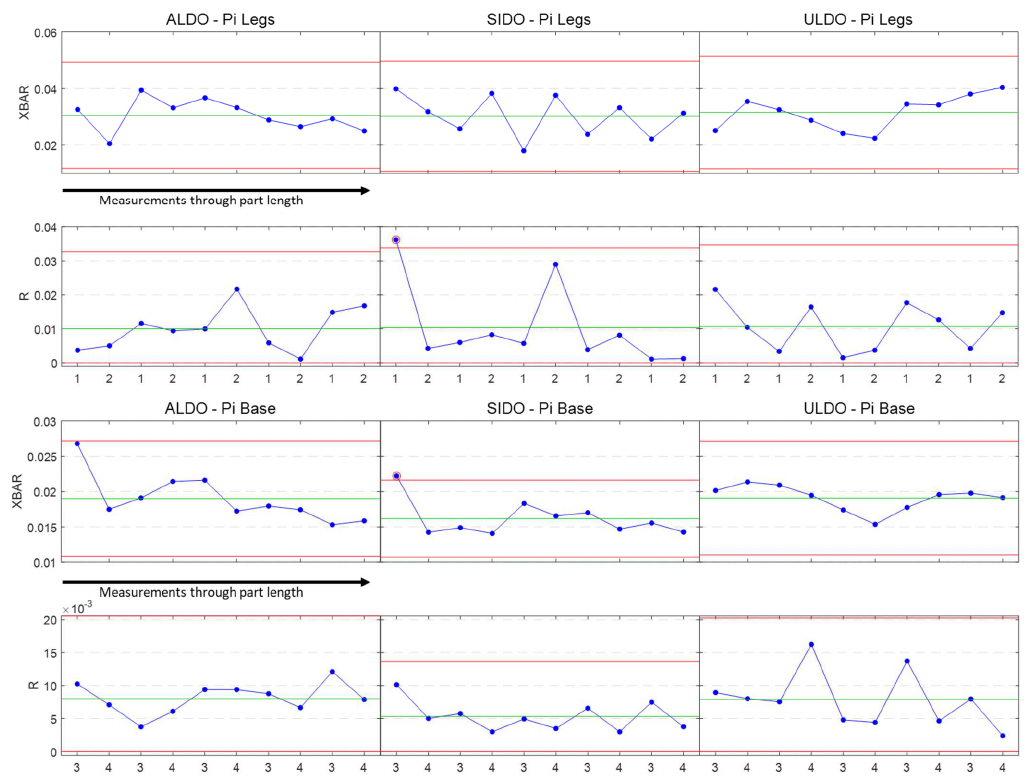
Figure 11. Control charts measuring change in crimp TT in flow-“down” parts (ALDO, SIDO, ULDO).